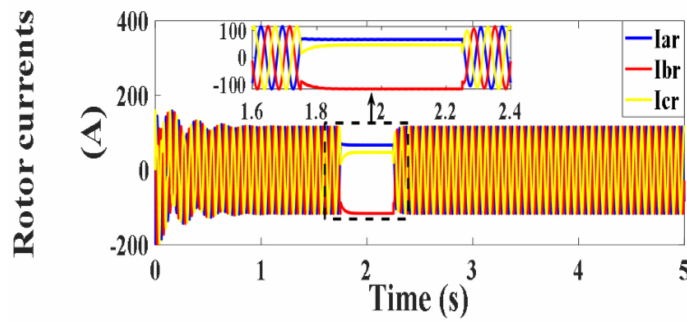
Figure 15. Rotor currents under SVOC (A).